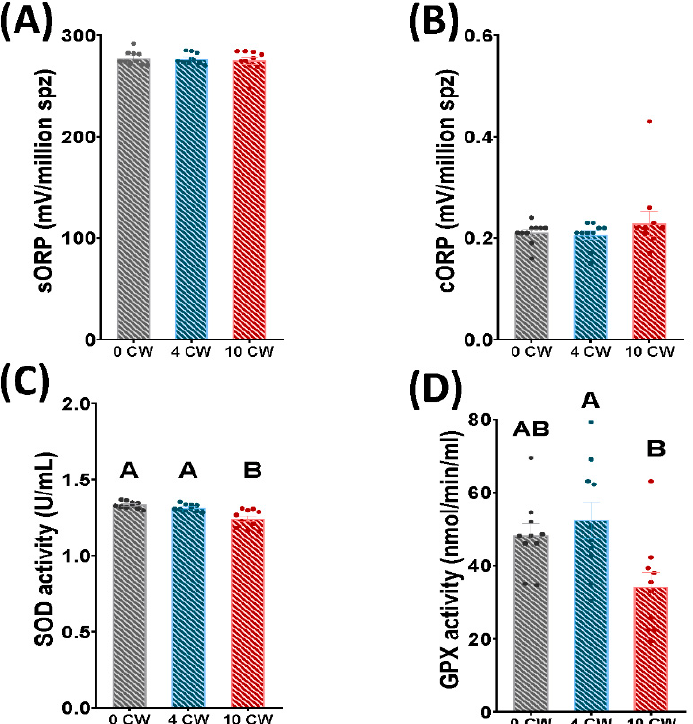
Figure 4. Ram sperm MiOXSYS ® indexes and, GPX and SOD enzymatic activity in frozen-thawed samples depending on the sperm collection frequency: without sperm collection (0 CW), 4 sperm collections per week (4 CW), 10 sperm collections per week (10 CW). ( A ) Integrated balance of oxidants and reductants (sORP, μ C/10 6 sperm); ( B ) Capacitance ORP (cORP, mV/10 6 sperm); ( C ) Superoxide dismutase (SOD) activity (U/mL); ( D ) Glutathione peroxidase (GPX) activity (nmol/min(ml). Significant differences ( p < 0.05) among experimental groups in frozen-thawed samples are represented with different letters. The same ten males were analyzed in each experimental group.